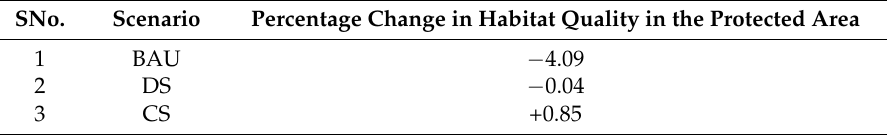
Table 4. Percentage change in habitat quality in the protected